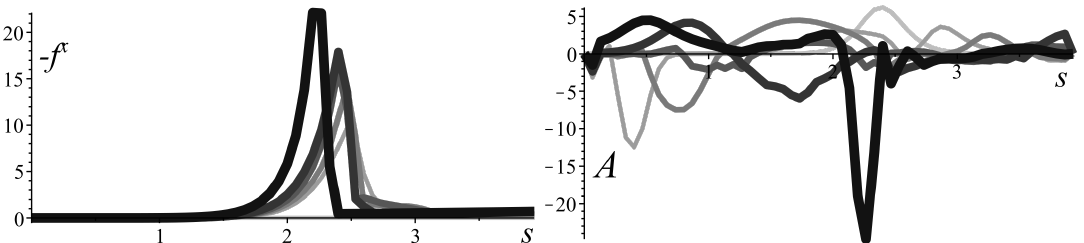
Figure 6. Evolution of the electromagnetic force − f x and the work on gas A for the second experiment.